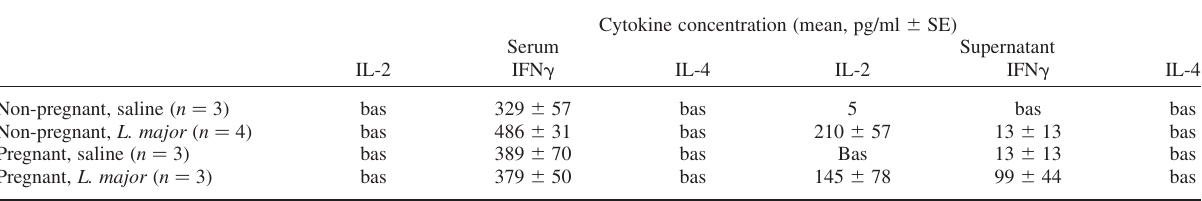
TABLE I Cytokine concentrations ð mean ^ SE Þ in serum (primary immunization) and from supernatants of spleen cell cultures (recall study) of L. major -immunized pregnant and non-pregnant CD-1